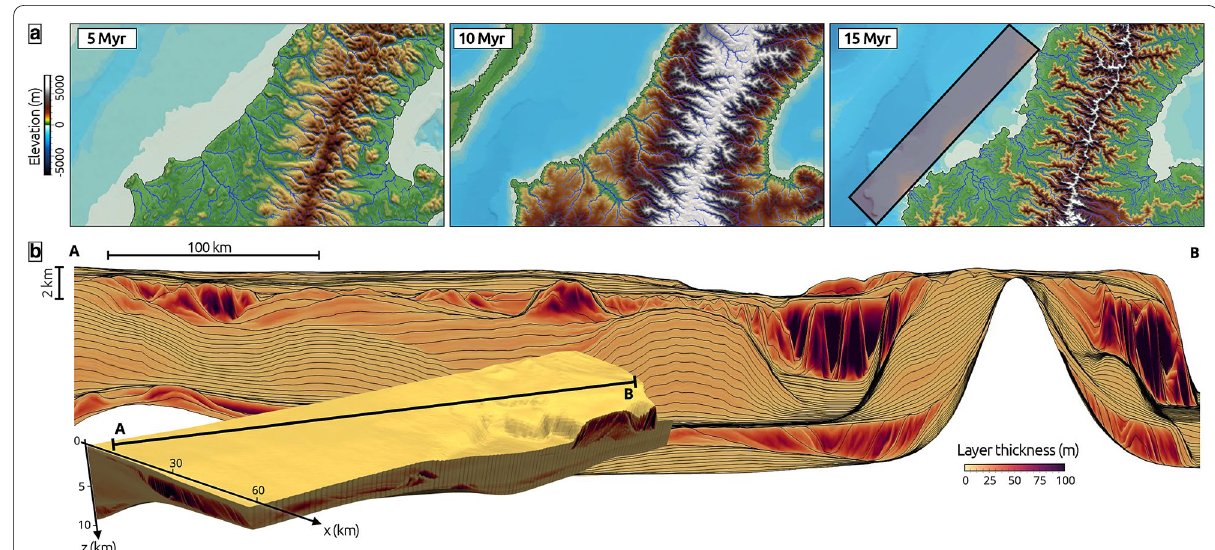
Fig. 1 A Landscape evolution model outputs showing simulated elevation changes over time induced by spatially variable tectonic regimes and climatic (sea-level and precipitation) forcings. B Bottom panel shows recorded stratigraphic architecture after 20 Myr extracted as a 3D volume for the shaded red box defined in A . The volume can be sliced in all directions, here the cross-section A-B is visualized and coloured based on individual layer thicknesses. Contour lines are drawn every 250